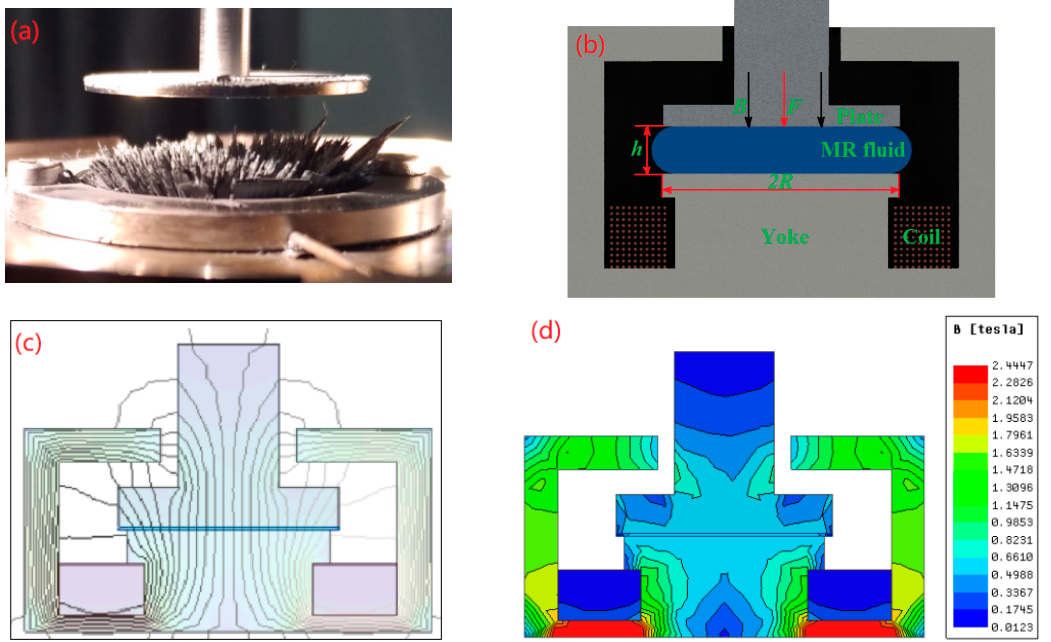
Figure 1. MR experimental setup. ( a ) MR fluid at applied magnetic field for MCR 302 rheometer; ( b ) Schematic of the test system; ( c ) Magnetic induction lines of the rheometer under 3A current; ( d ) Magnetic flux density distribution of the rheometer under 3A current.